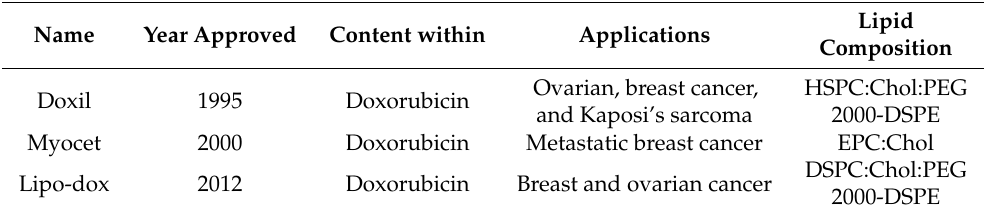
Table 3. The approved liposome-based delivery systems are used as treatments against breast cancer